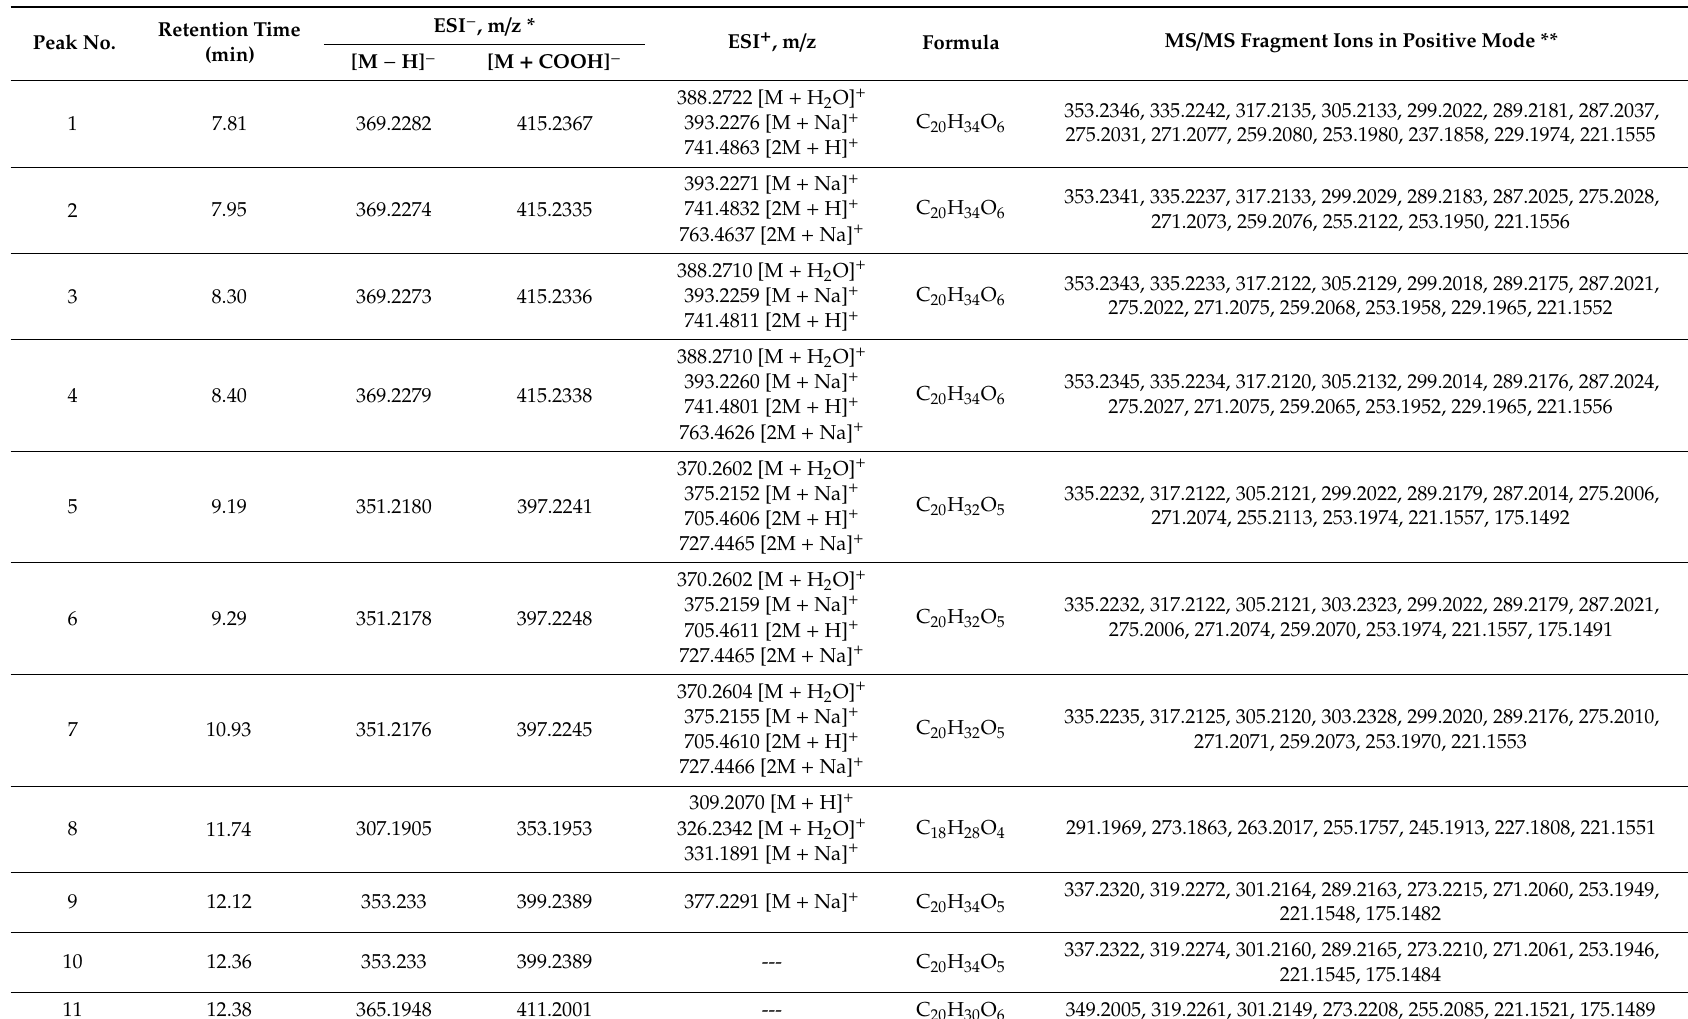
Table 1. Foskolin-type diterpenoids of B. aromatica screened using the MDF method. Peak